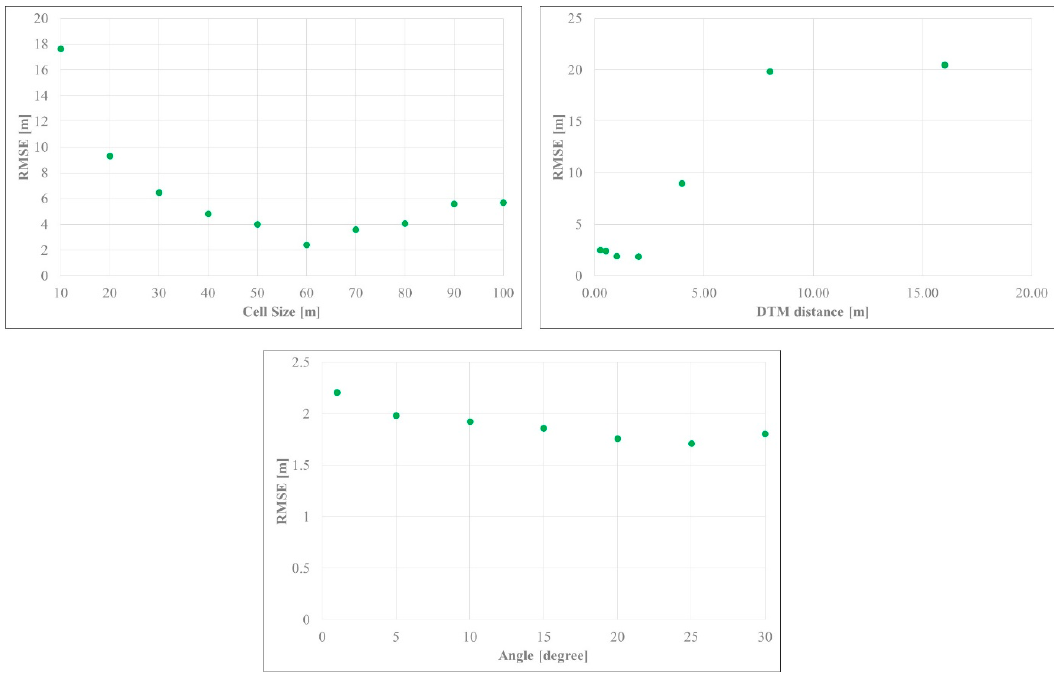
Figure 2. Root mean square error (RMSE) of tree heights in terrain models generated using various parameter settings to extract the ground points.